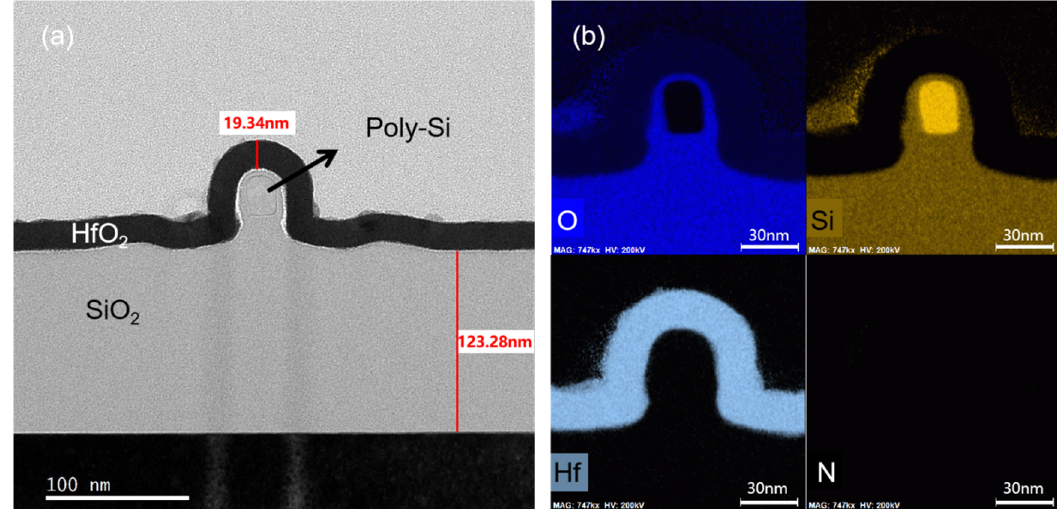
Figure 4. ( a ) TEM image of poly-Si NW channel of the device, ( b ) EDS elemental mappings of O, Si, Hf and N, respectively.